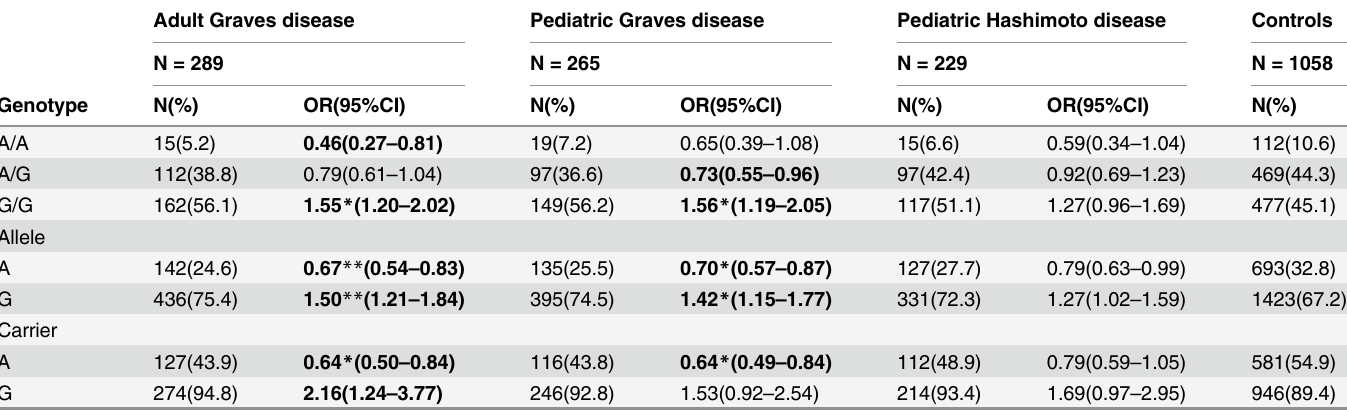
Table 2. Polymorphism of +49A/G (rs231775) of the CTLA4 gene in adult Graves disease, pediatric Graves disease, Hashimoto disease patients and